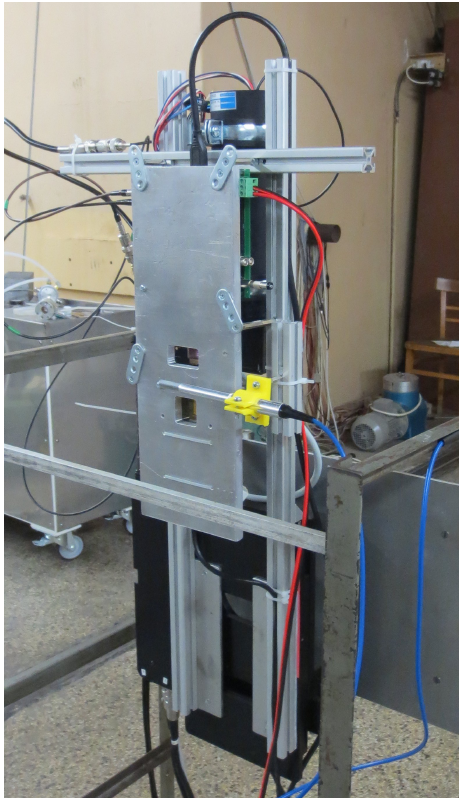
Figure 3. Irradiation setup with the Farmer PTW 30010 ionization chamber and the Timepix